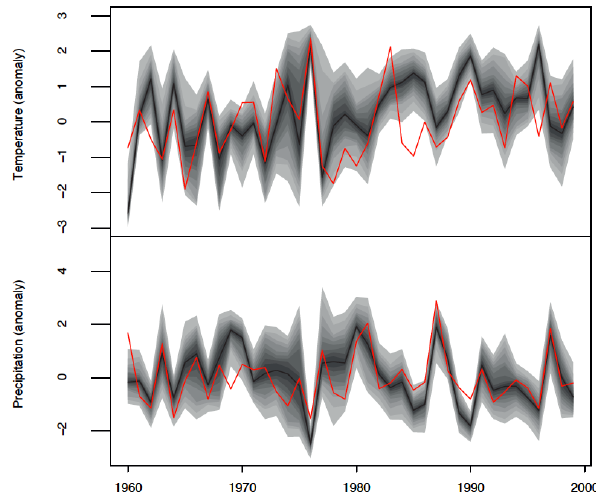
Figure 6. Comparison with modern climatological records (1960– 1999). Median reconstructed values correspond to the black curve, observations are in red. The quantiles between 2.5 and 97.5 fall within the gray